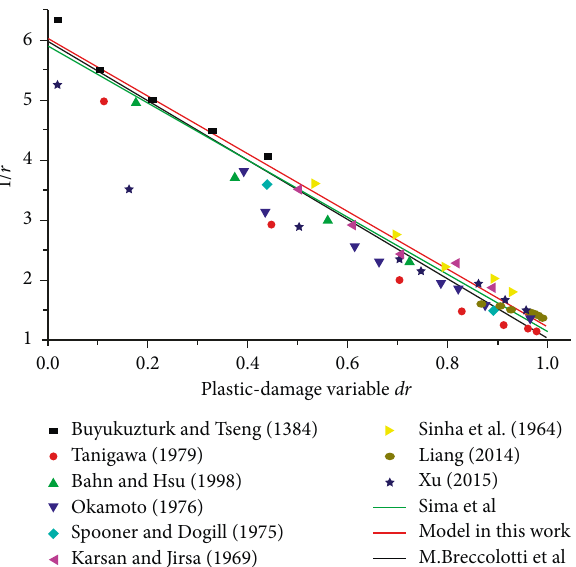
Figure 12: Comparison of 1/ r vs. dr between SCC and typical NVCs [23, 24] under